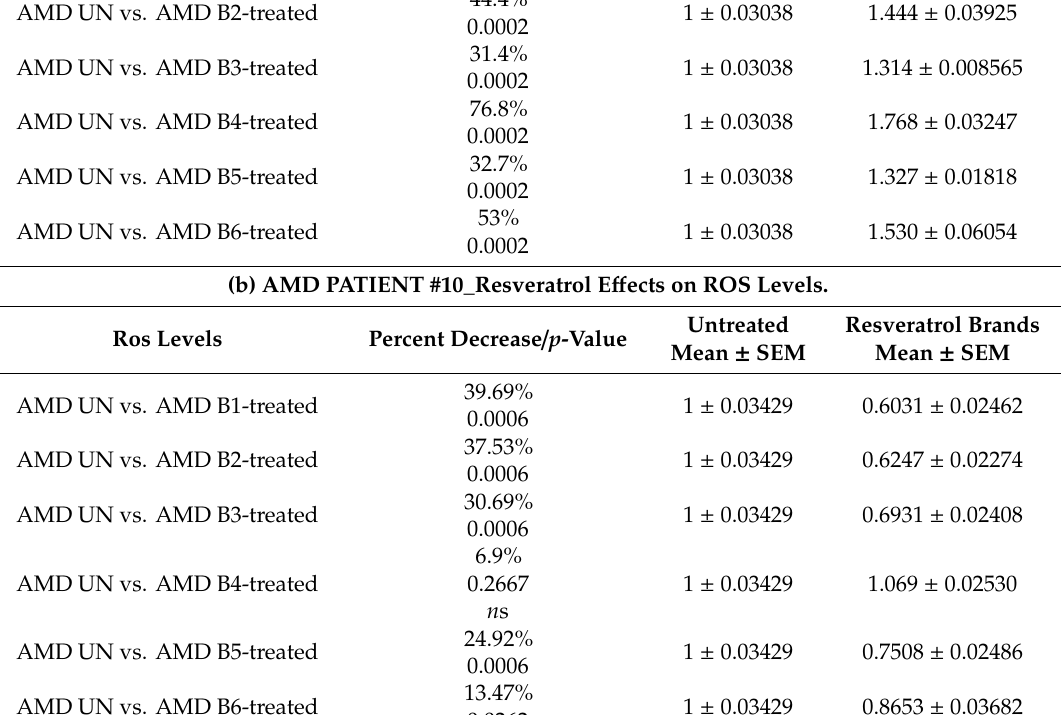
Table 12. E ff ects of resveratrol formulations on cell viability ( a ) and ROS levels ( b ) in AMD patient # 10. (a) AMD PATIENT #10_Resveratrol E ff ects on Cell